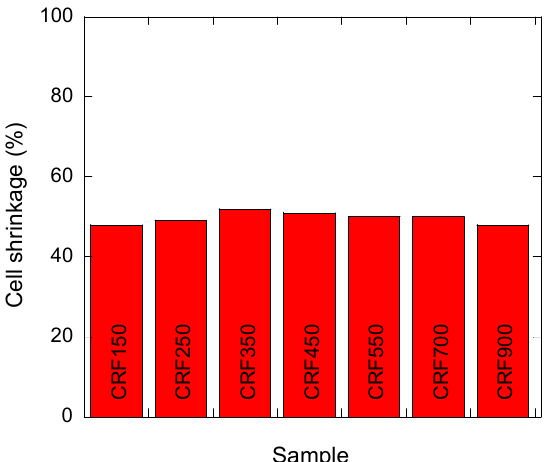
Figure 10. Cell shrinkage calculated for all of the materials, thanks to which carbon monoliths of predictable cell size can be prepared.